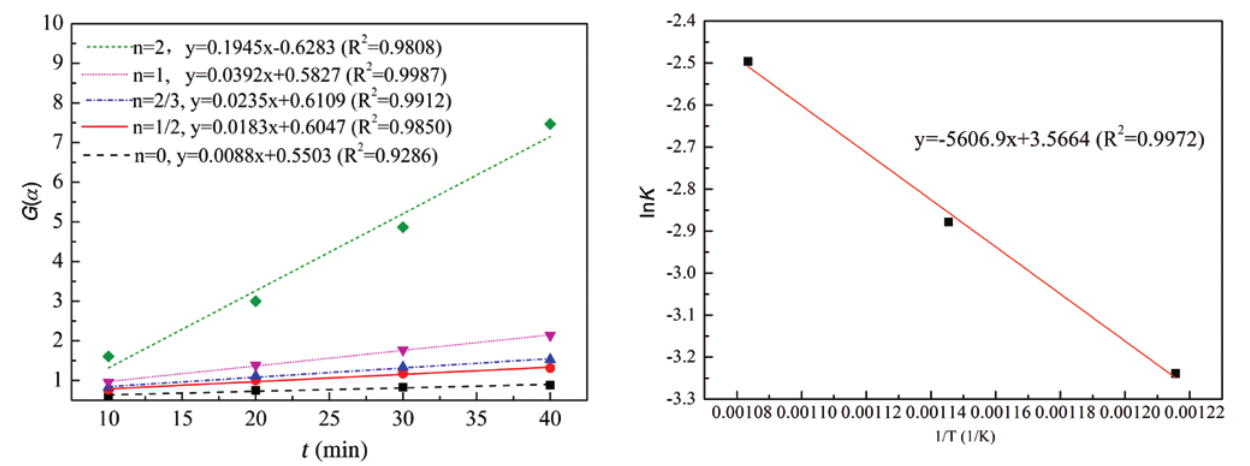
Figure 13: Relationship between ln K and 1/T for the zinc oxide